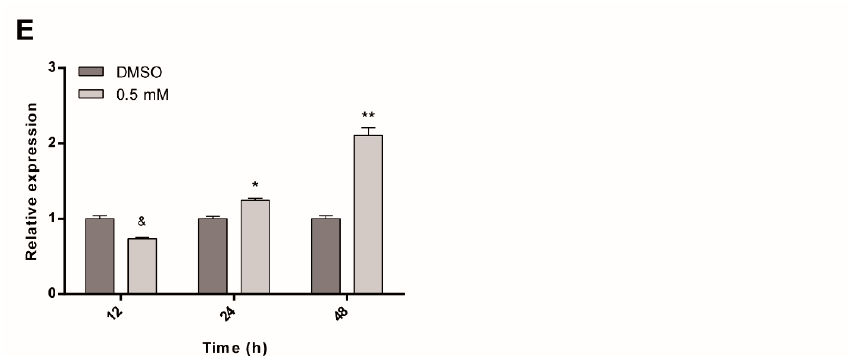
Figure 7. Regulation of expression levels of MDRs genes under ASA treatment. ( A ) giABC. ( B ) giABCP. ( C ) giMDRP. ( D ) giMRPL and ( E ) giMDRAP1. The values are expressed as mean ± SD ( n =